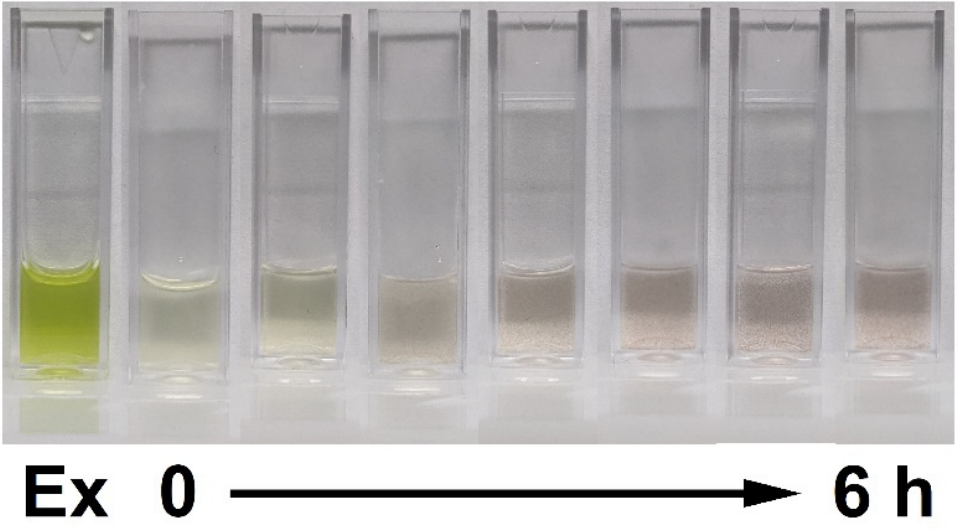
Figure 1. Solution color change of the upland cress extract and gold (III) chloride trihydrate mixture during the incubation period. Time interval: 1 h.